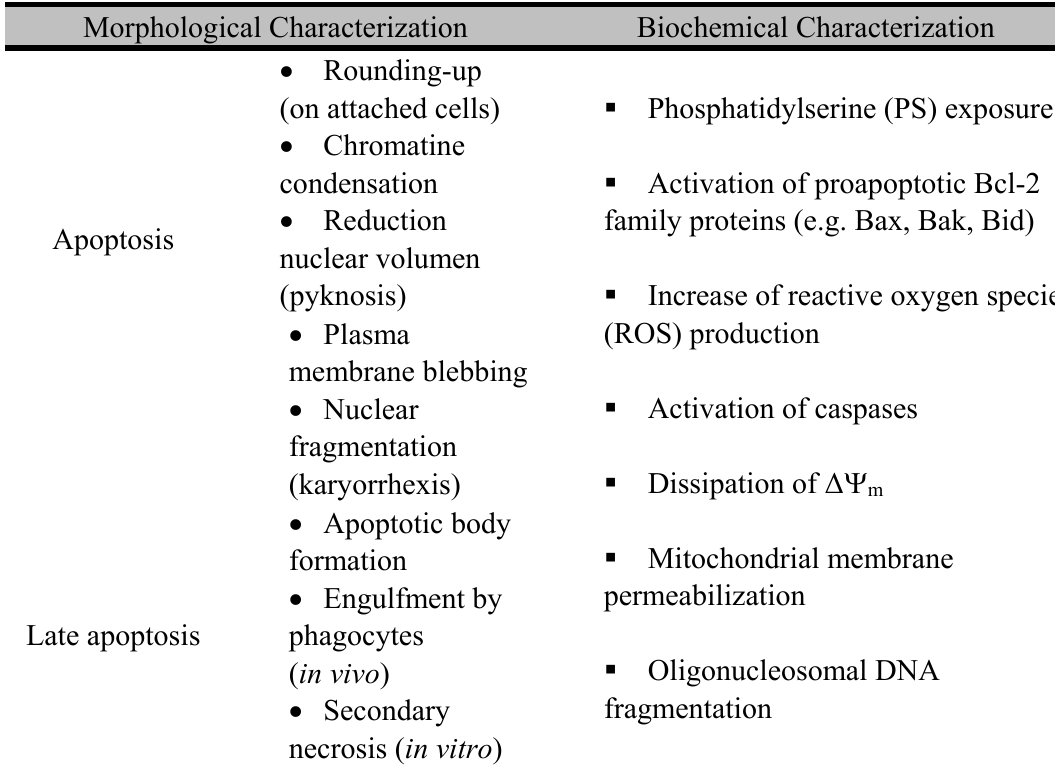
Table 1. Main morphological and biochemical markers of apoptosis. Column on the left represents main morphological changes during the apoptotic process; column on the right summarizes main biochemical markers of the apoptotic cell